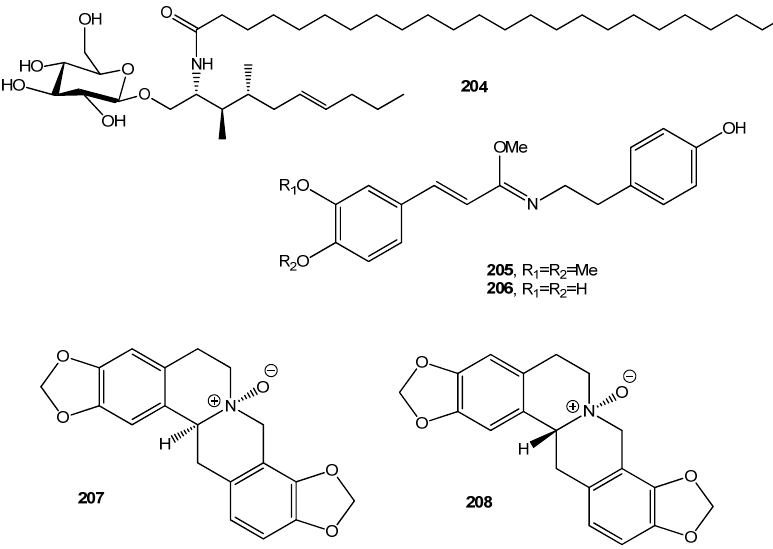
Figure 15. The structures of compounds 204–208.